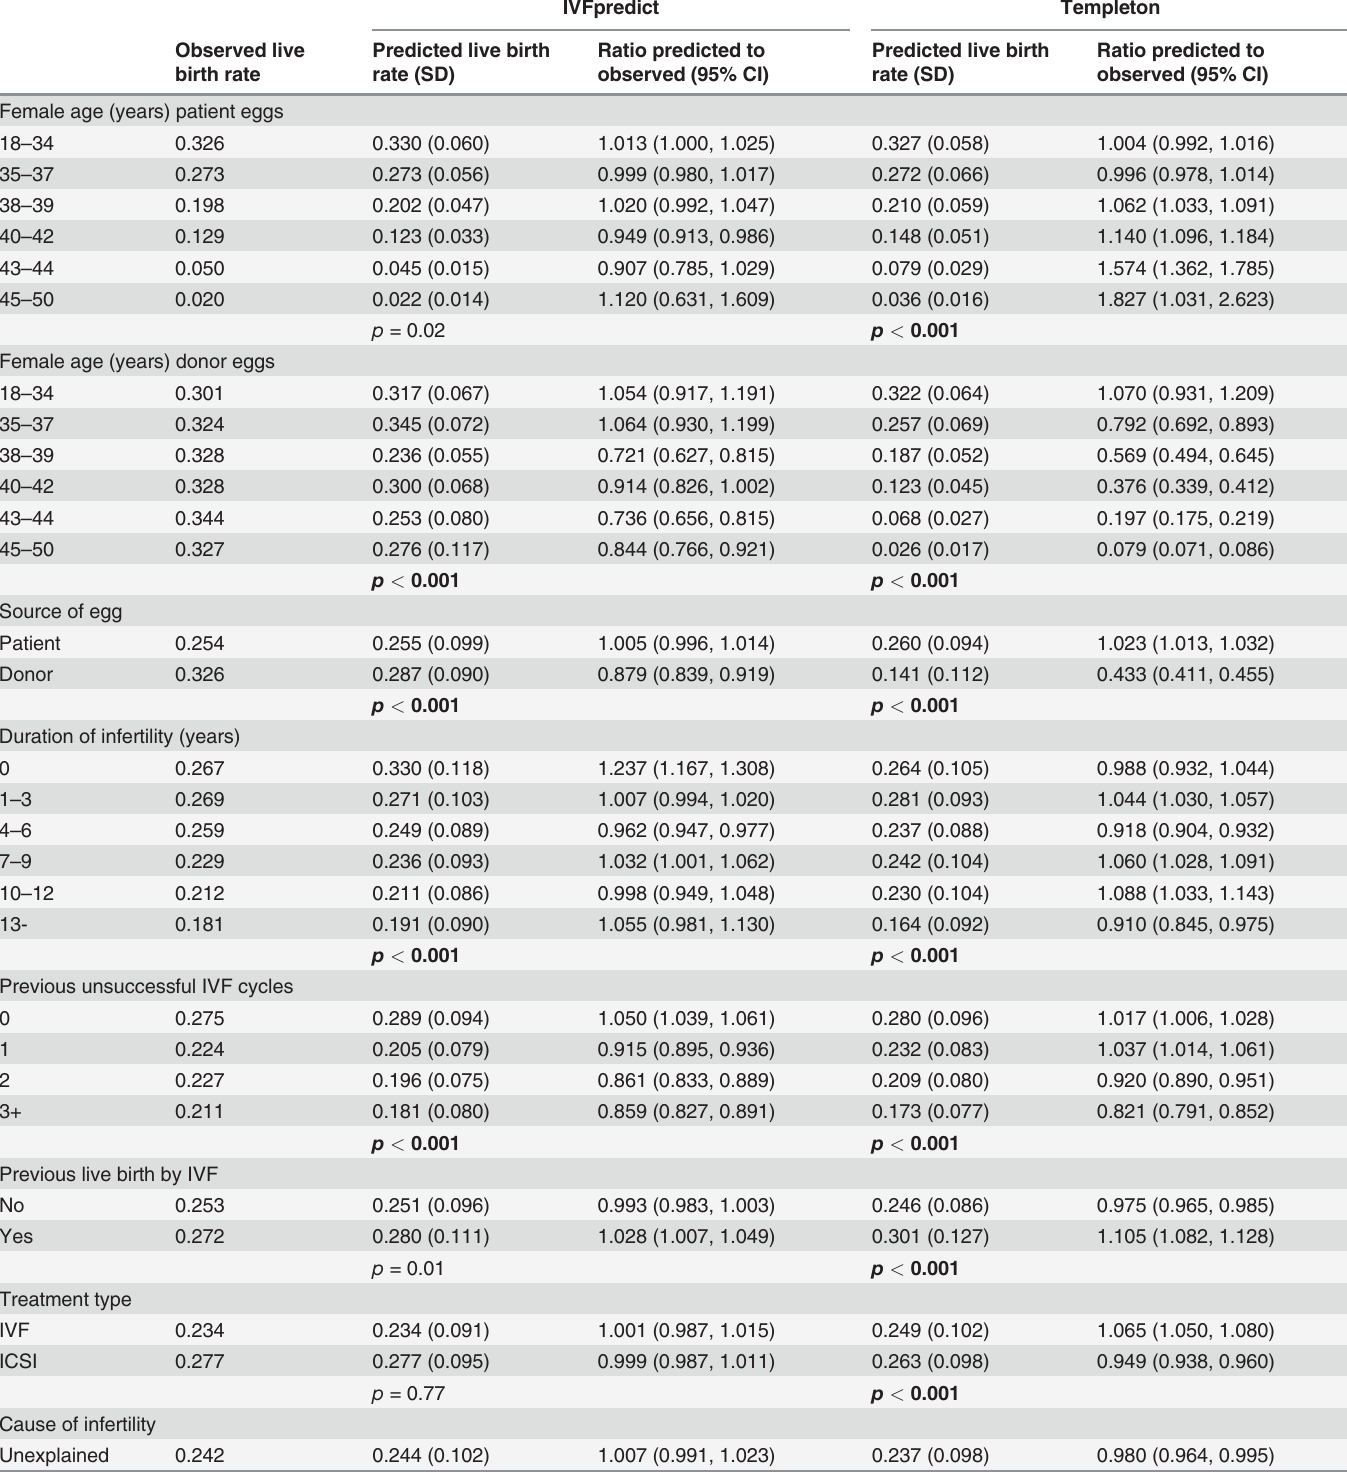
Table 3. Observed and predicted live birth rates from updated IVFpredict and Templeton models stratified by characteristics of patients and treat- ment, in 130,960 IVF